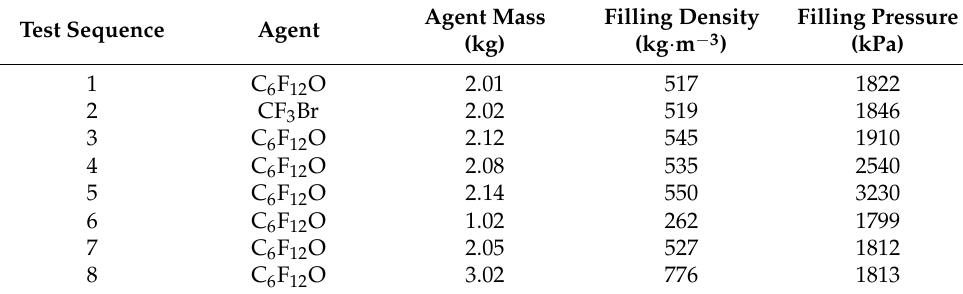
Table 1. The discharge tests of the C 6 F 12 O and CF 3 Br